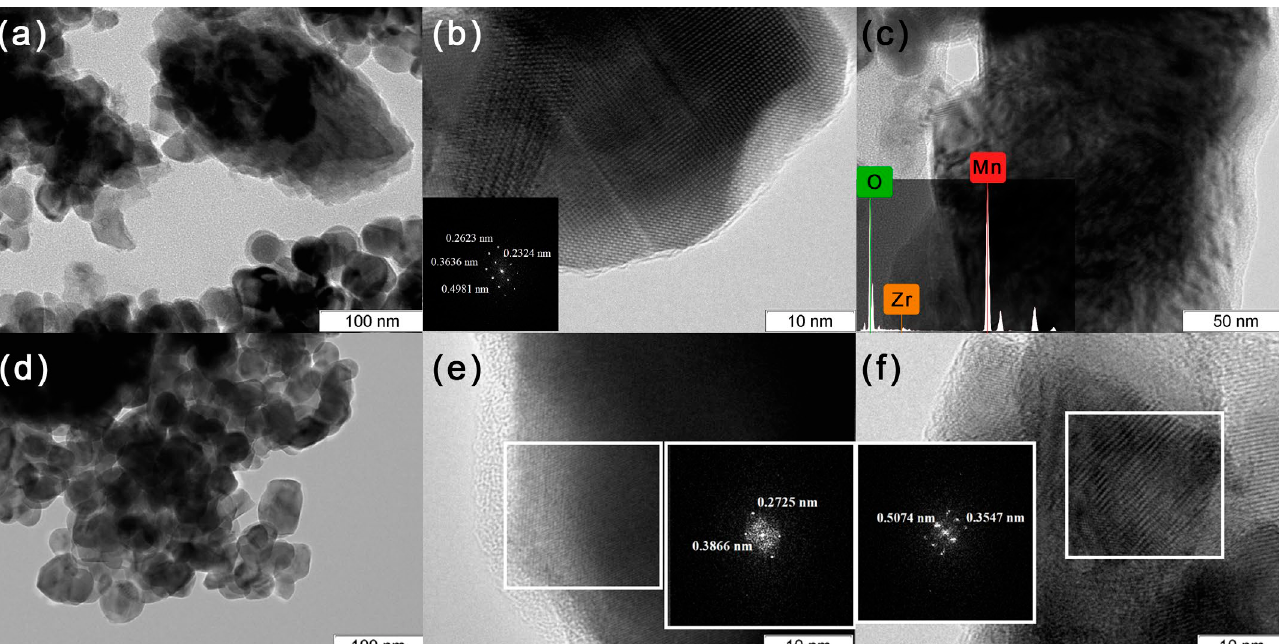
Figure 3. TEM images ( a , d ); with FTT image ( b , e , f ); with EDX spectra ( c ) of the IM-400 ( a , b , c ) and IM-650 ( d , e , f ) catalysts.